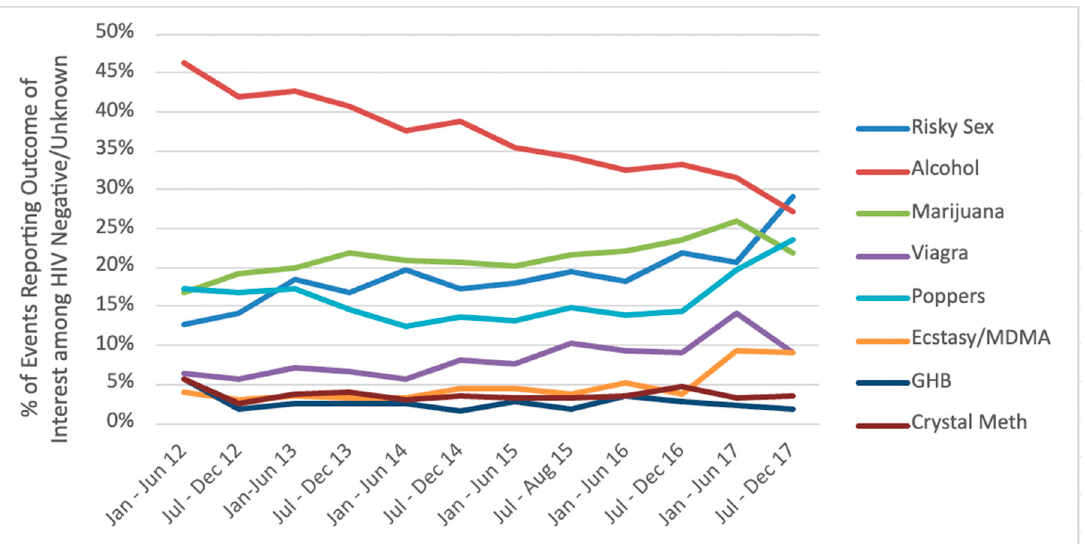
Figure 1. Percentage trends of sexual events reporting substance use and higher risk anal sex among HIV-negative/unknown gbMSM in Metro Vancouver. Notes: MDMA = 3,4-methylenedioxymethamphetamine; GHB = 3,4-methylenedioxymethamphetamine For trends among HIV-positive gbMSM, our model found higher risk anal sex in- creased over time (first time period prevalence: 16%, last time period prevalence: 38%) (OR = 1.006; 95% CI = 1.001, 1.012, p = 0.025). In relation to event-level substance use, we found that popper use decreased over time (first time period prevalence: 38%, last time period prevalence: 31%) (OR = 0.991; 95% CI = 0.984, 0.998, p = 0.007). Full results can be found in Figure 2.